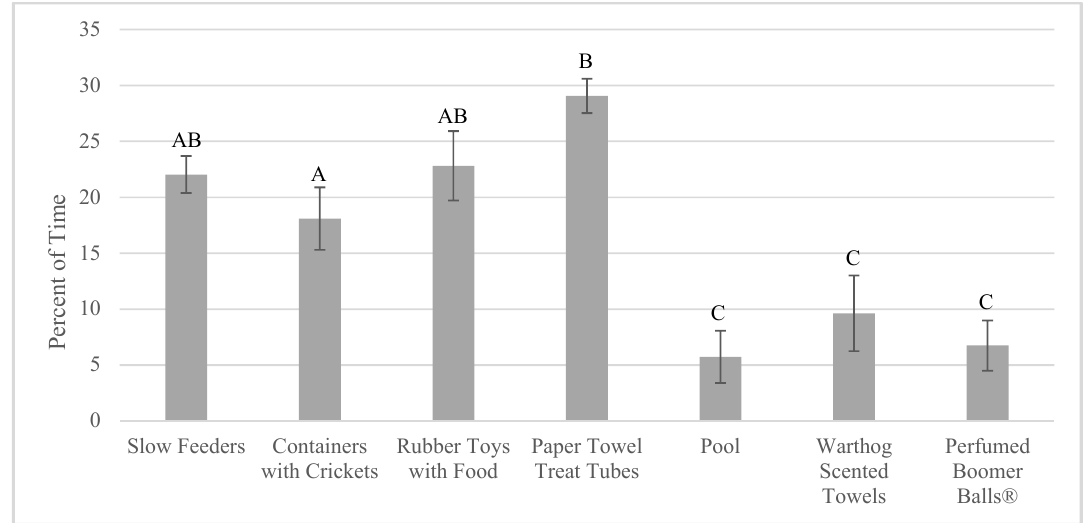
Figure 3. Percent of total time foraging when each enrichment item was available (mean ± SE; n = 4). Significant pairwise comparisons ( p < 0.05) are noted on the graph with different uppercase letters. Pairwise comparisons can be found in Table S5.